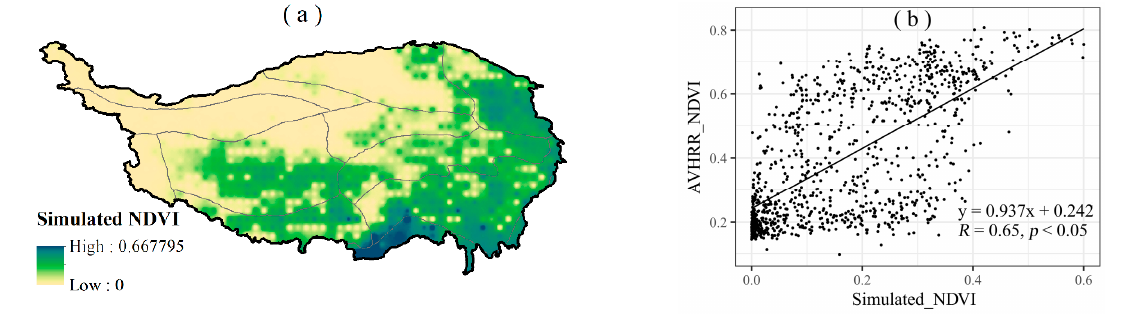
Figure 7. Spatial distribution of the mean annual value of simulated NDVI of the QTP from 1982 to 2019 ( a ). Scatter-plot comparison of AVHRR NDVI with simulated NDVI ( b ).